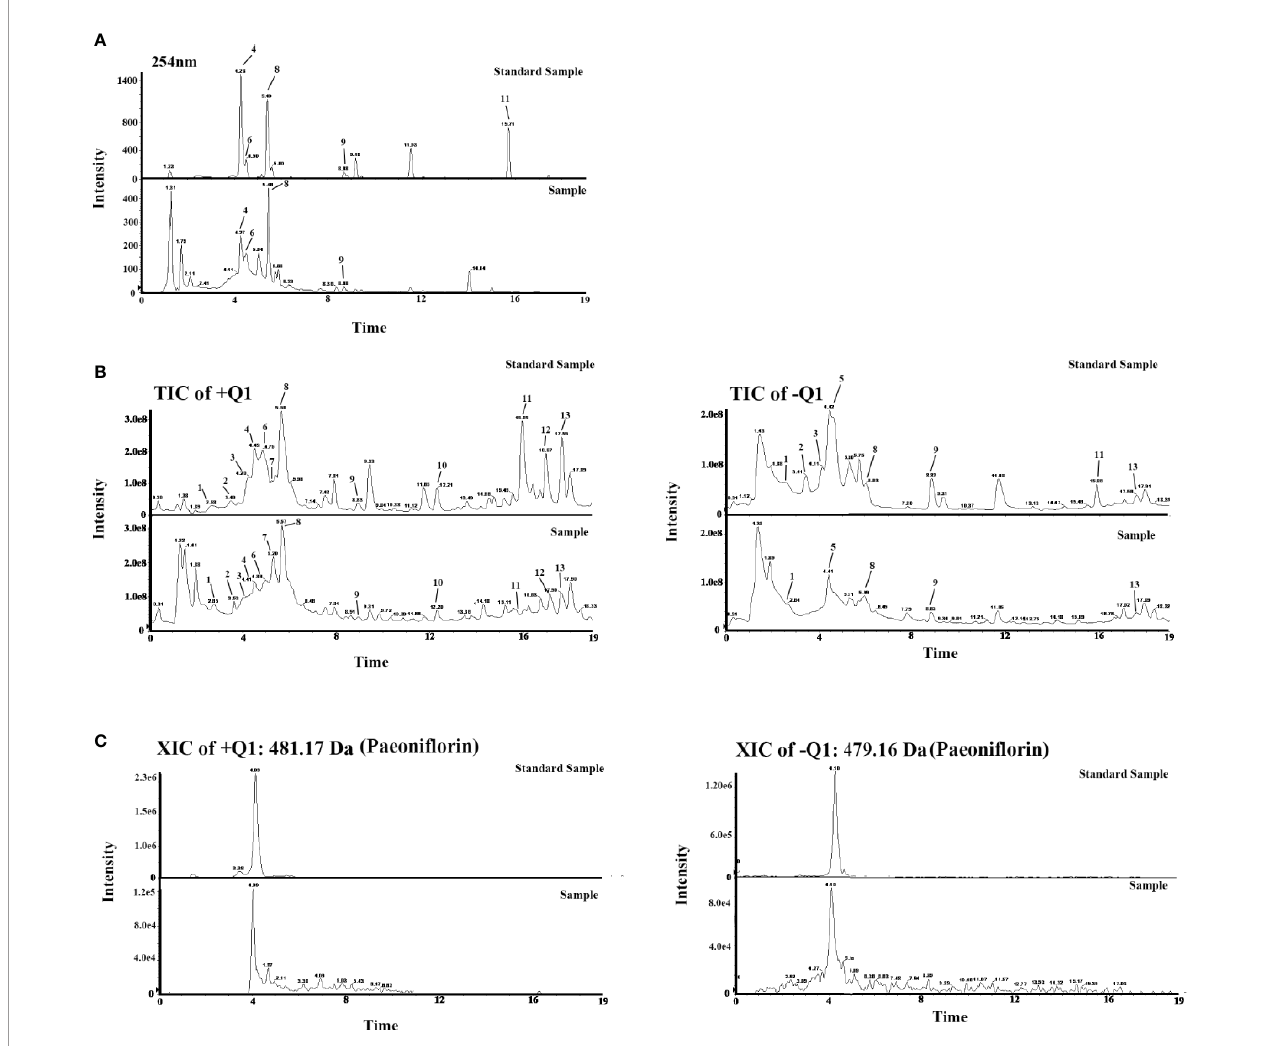
FIGURE 4 | (A) Chromatograms of LCW and standard samples. (B) Total ion Current (TIC) chromatograms of LCW and standards samples. (C) Extracted ion current (XIC) chromatograms of paeoni fl orin in LCW and standard samples. 1) Hydroxysaf fl or-Yellow-A, 2) Amygdalin, 3) Paeoni fl orin, 4) Caffeic Acid, 5) Phillyrin, 6) Liquiritin, 7) Peimisine, 8) Harpagoside, 9) Rhein, 10) Z-Ligustilide, 11) Berberine, 12) Tanshinone II a, and 13) Catalpol.